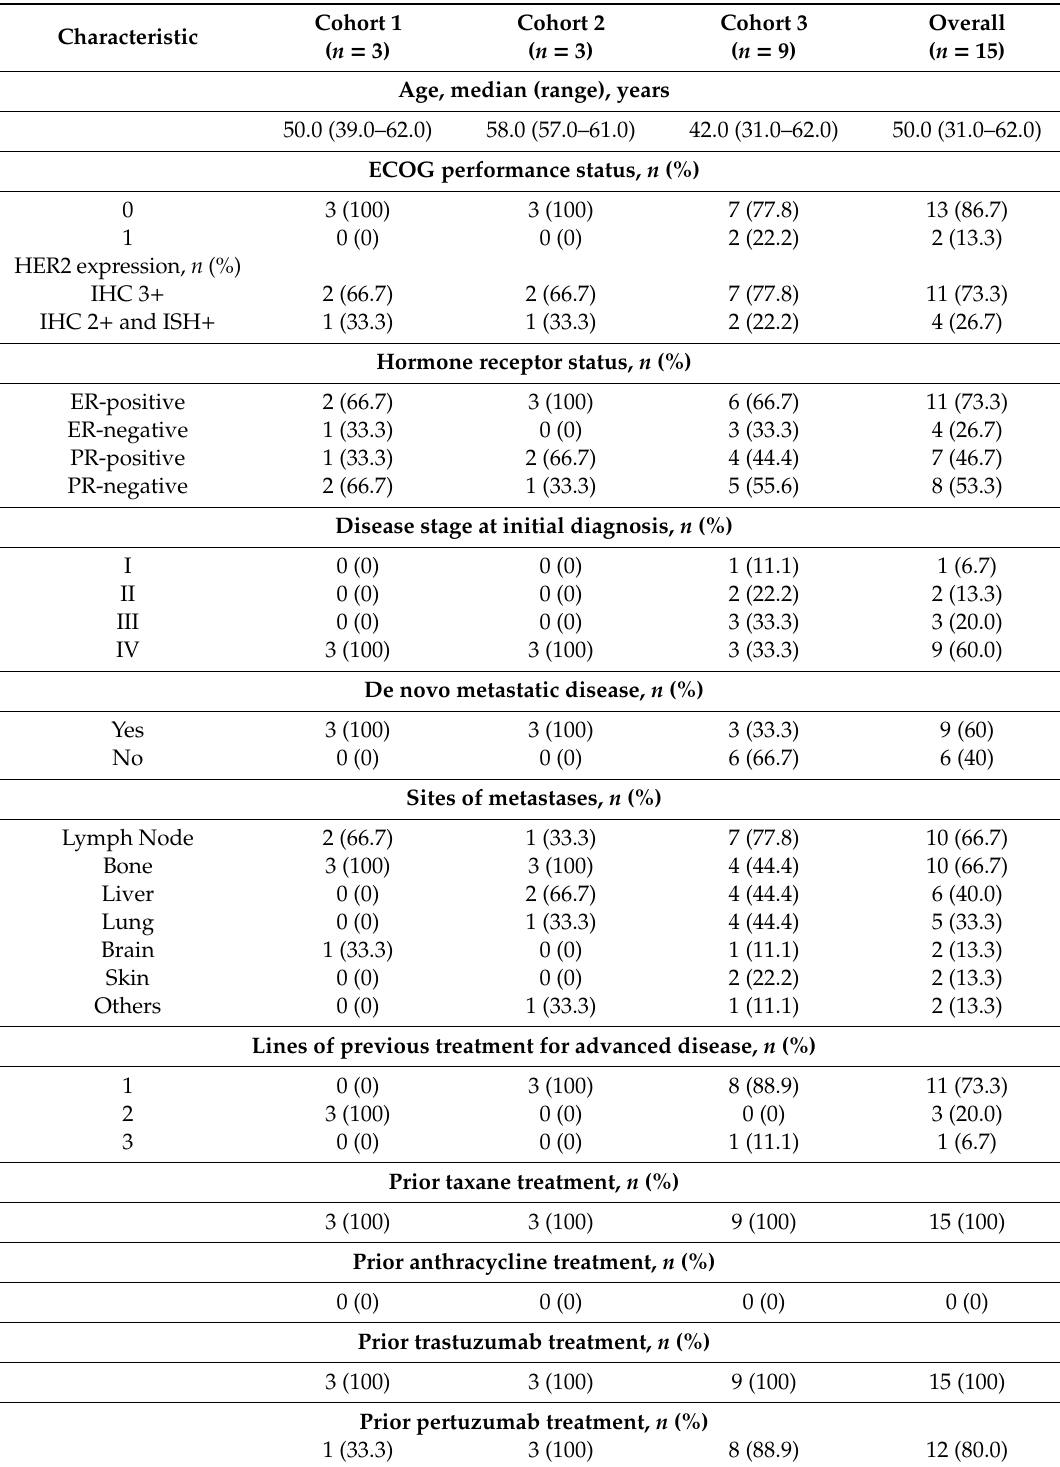
Table 1. Demographic and baseline patient